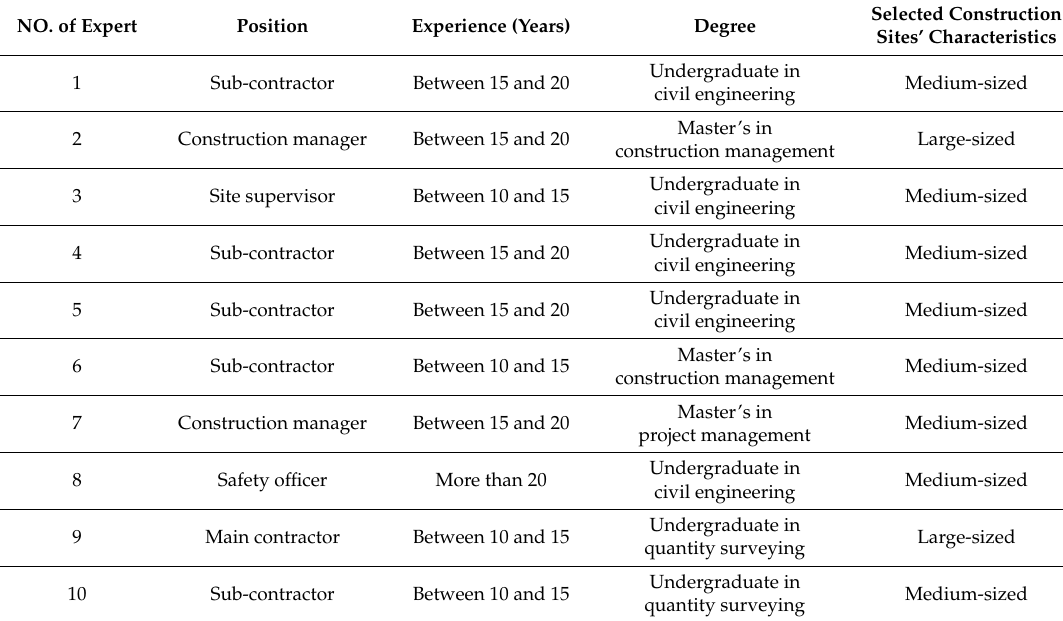
Table 1. Experts’ profile.